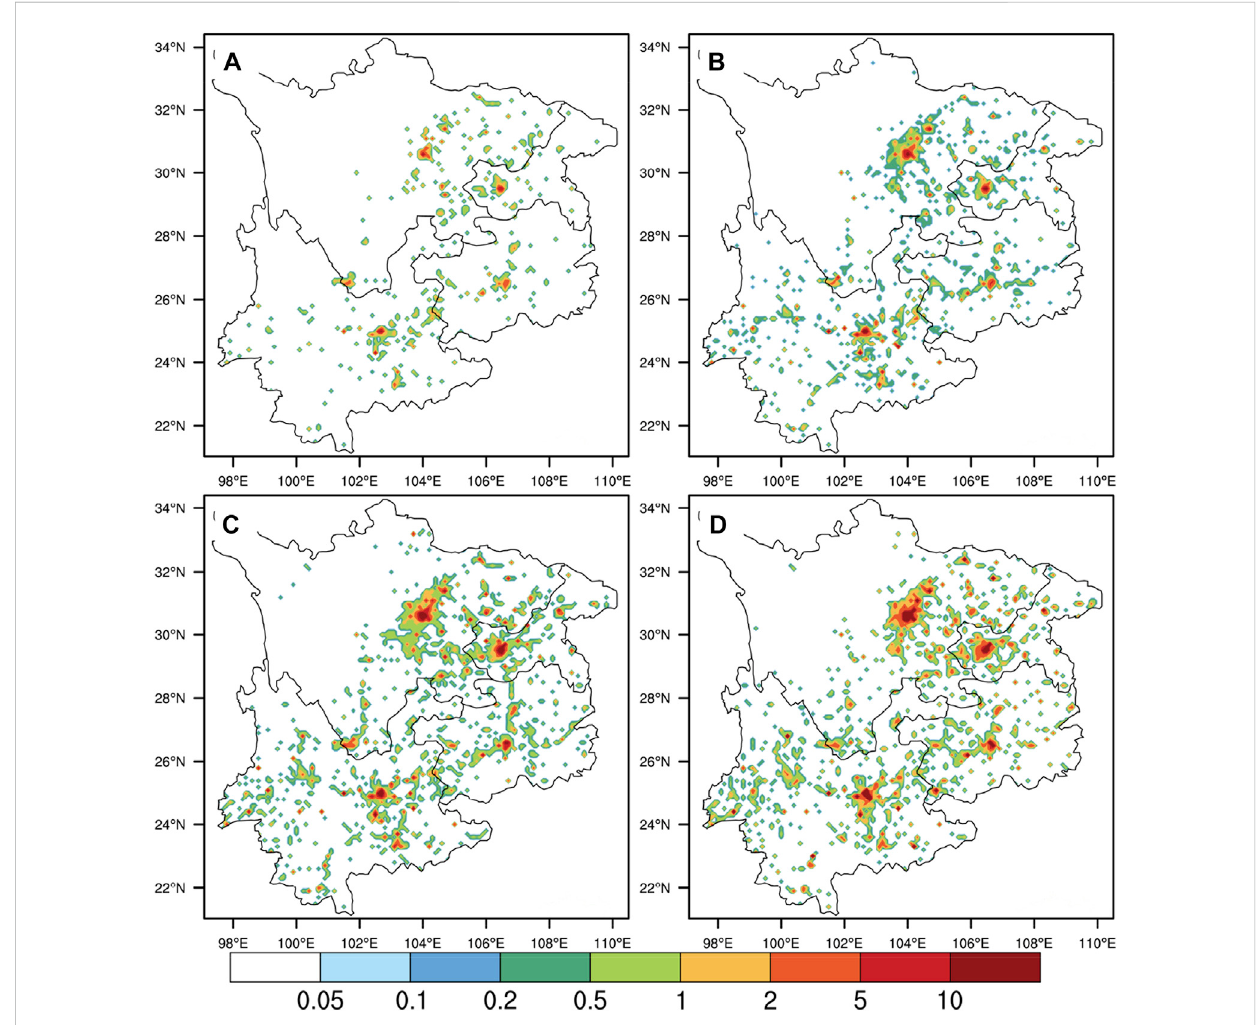
FIGURE 2 The distribution of AHR in southwest China (unit: W m -2 , resolution: 0.1 ° × 0.1 ° ): (A) in the year 1992; (B) in the year 2000; (C) in the year 2005; (D) in the year